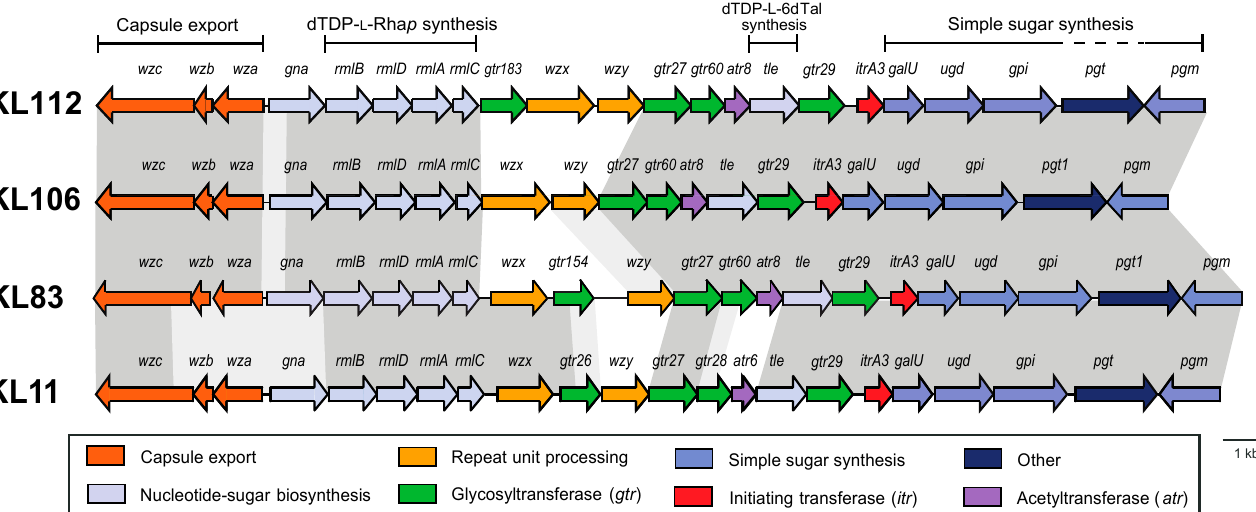
Figure 2. Comparison of the KL106 and KL112 with related A. baumannii CPS biosynthesis gene clusters containing the tle gene. Dark grey shading between gene clusters shows regions of >97% identity, whereas light shading is regions of 75–97% identity. Figure is drawn to scale from GenBank or WGS accession numbers MT152376.1 (KL112), MK399430.1 (KL106), KC526898.2 (KL83), and KF002790.2 (KL11). The scale bar and color scheme are shown below.